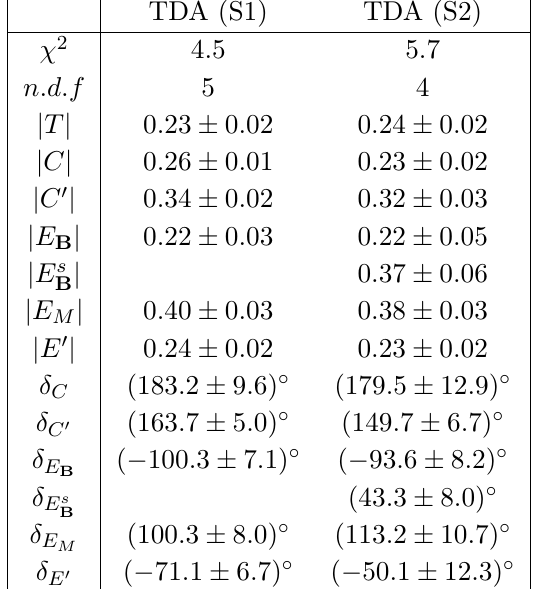
| , | E M | , | E 0 | ) are in units of GeV 3 , and n.d.f the B